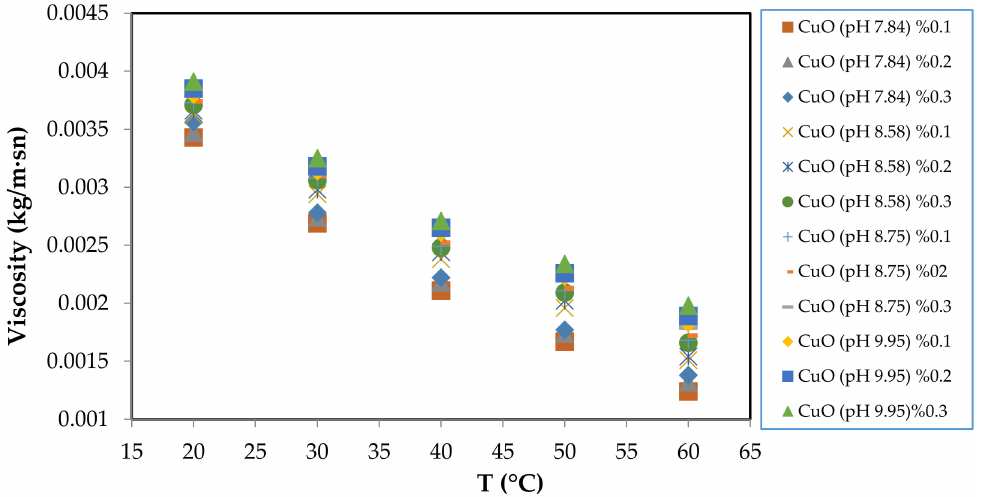
Figure 6. The experimental measurement of the viscosity of the CuO solution as a function of T with various pH values and weight % values.